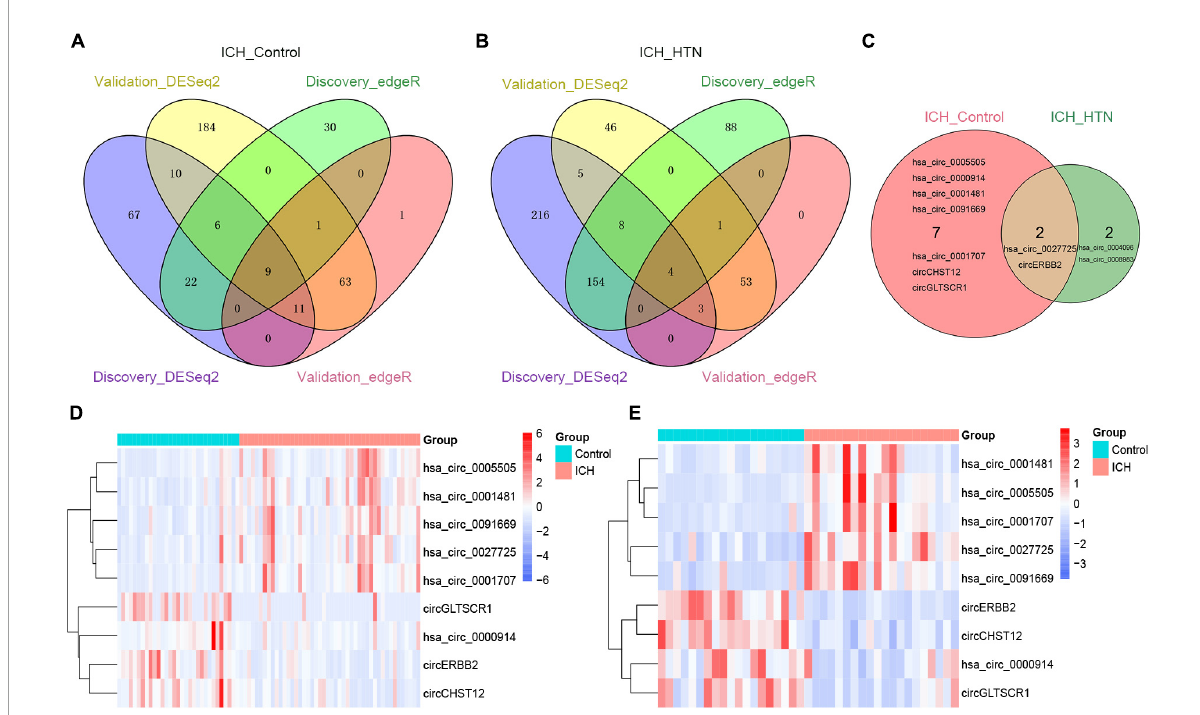
FIGURE3 Consistently differentially expressed circRNAs between intracerebral hemorrhage (ICH) and controls or hypertension (HTN) in the discovery and validation cohorts by DESeq2 and edgeR methods. (A) Venn diagram showing consistently altered circRNAs (fold change ≥ 1.5 and FDR < 0.05) in ICH patients compared with controls in the discovery ( n = 44 vs. 31) and validation cohorts ( n = 20 vs. 19) with both the DESeq2 and edgeR methods. (B) Venn diagram showing consistently altered circRNAs (fold change ≥ 1.5 and FDR < 0.05) in ICH compared with HTN in the discovery ( n = 44 vs. 42) and validation cohorts ( n = 20 vs. 18) with both the DESeq2 and edgeR methods. (C) Venn diagram showing the common altered circRNAs (fold change ≥ 1.5 and FDR < 0.05) in the ICH patients compared with healthy controls and ICH compared with HTN in both cohorts. Hierarchical clustering of nine consistently differentially expressed circRNAs between ICH patients and healthy controls in the discovery ( n = 44 vs. 31) (D) and validation ( n = 20 vs. 19) (E) cohorts. Blue represents downregulated circRNAs, red represents upregulated circRNAs, and white represents no changes in circRNA expression. The column represents a sample, and each row represents a single circRNA. The red color label represents the ICH group, and the green color label represents the healthy control group. The label color scales indicate the circRNA relative expression levels in the ICH and control groups.